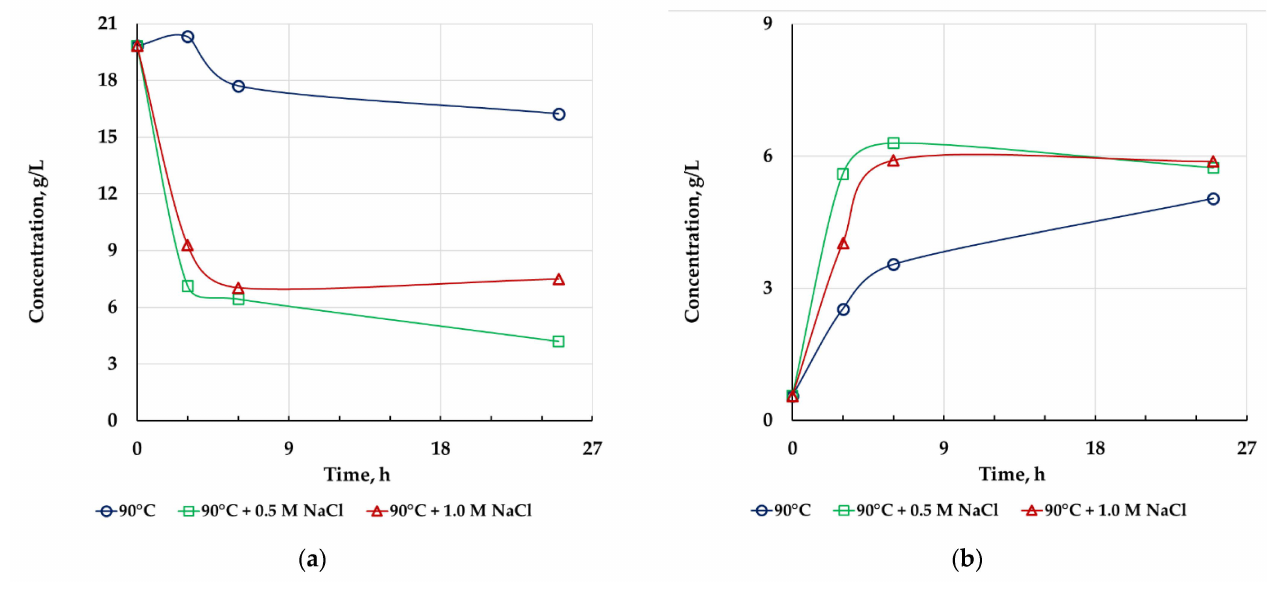
Figure 4. Changes in Fe 3+ ( a ) and Fe 2+ ( b ) ion concentrations during chemical leaching of bioleaching residues under different conditions. Table 4. Metal extraction into the liquid phase during chemical leaching of bioleaching